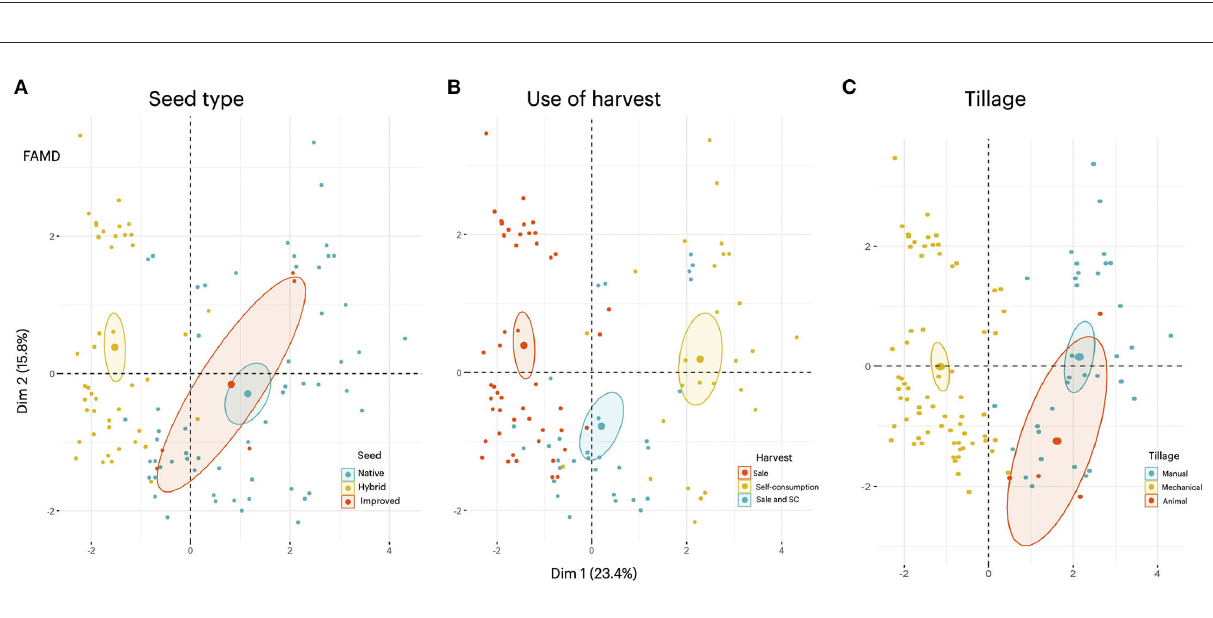
improved variety (red) is used by 5% of farmers; hybrid seed (yellow) is used by 35% of farmers (Figure 4A). Then, concerning harvest use, food self-sufficiency (yellow) is practiced by 45% of farmers; harvest for sale (red) is practiced by 26.5% of farmers; and mixed- use (green), characterized by selling the crop and storing it for